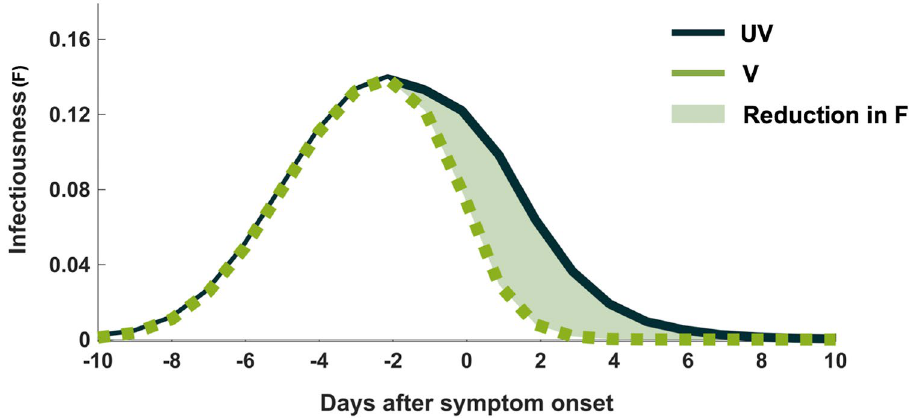
Figure 1. An illustration of the infectiousness profile for infections in unvaccinated individuals (UV) extracted from 18 and the estimated infectiousness profile for vaccine breakthrough infections (V). The light green shade indicates a reduction in infectiousness ( F ) in vaccinated individuals due to faster viral